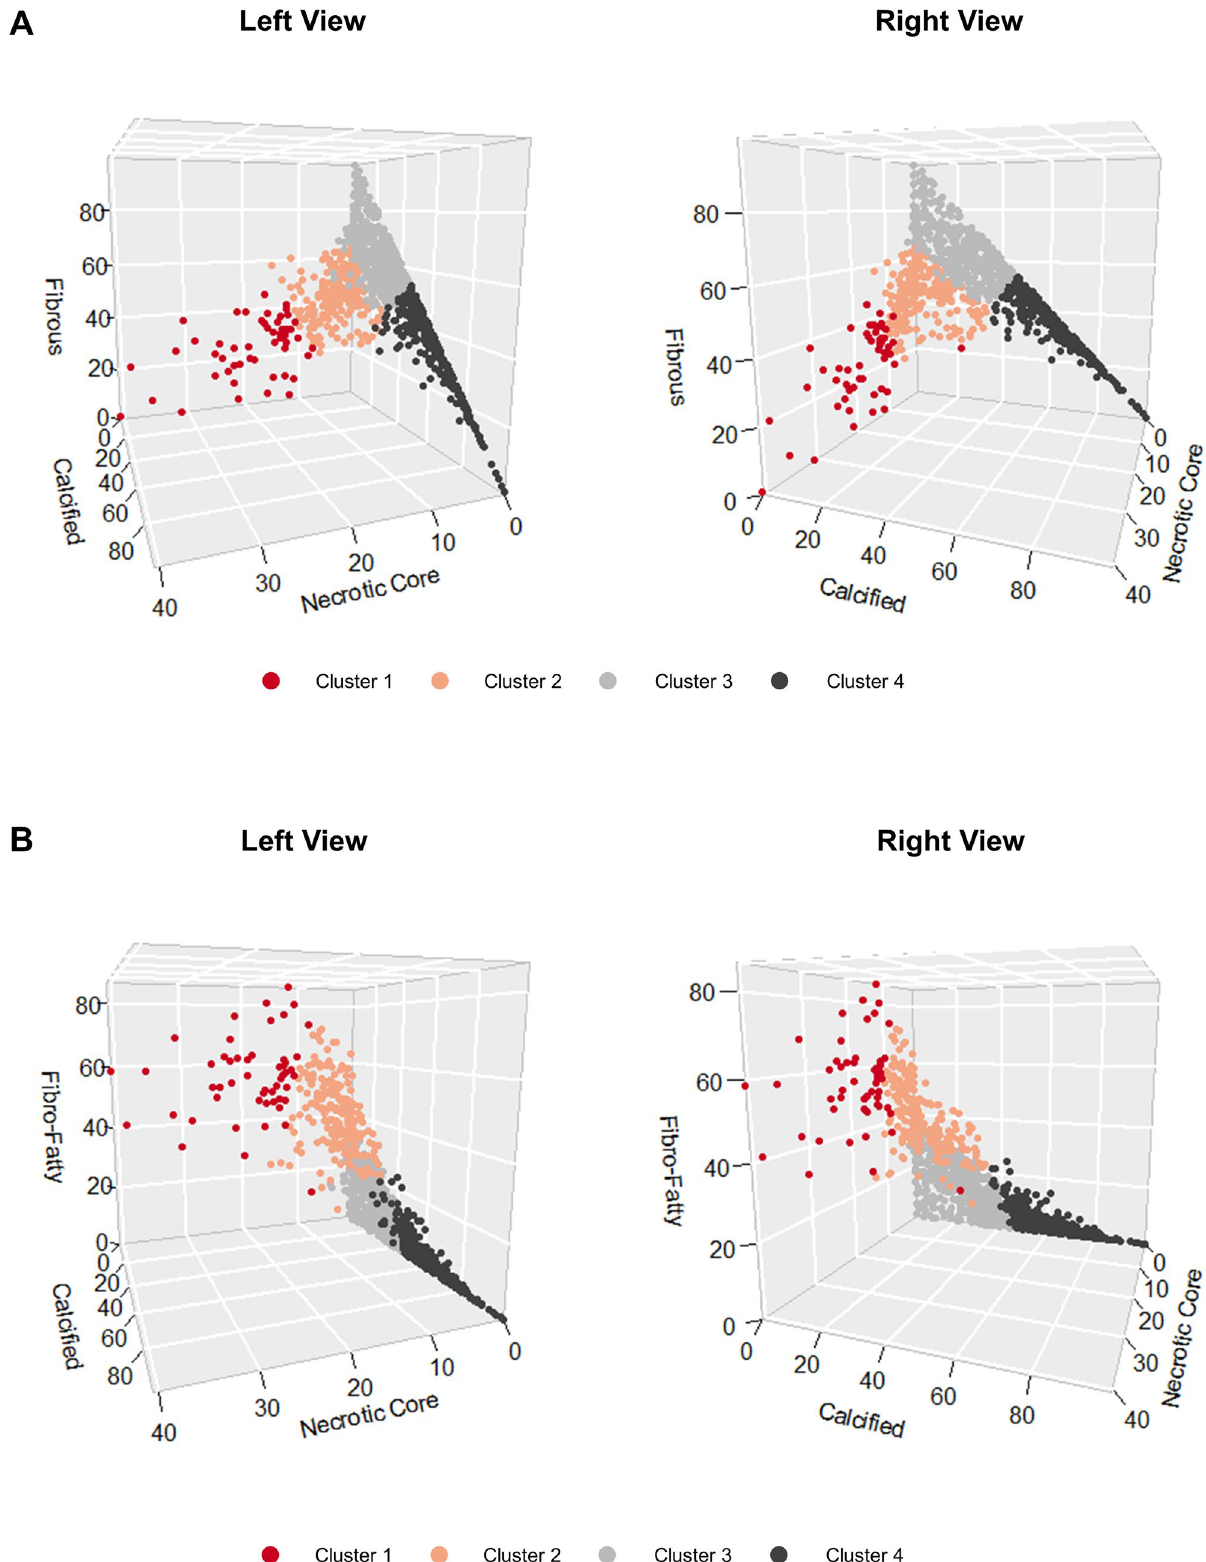
Figure 3. Three-dimensional (3D) plots visualizing the clusters. 3D plots visualizing the clusters ( A ) using the percent volumes of the necrotic core, fibrous plaque, and calcified plaque, and ( B ) using the percent volumes of the necrotic core, fibro-fatty plaque, and calcified